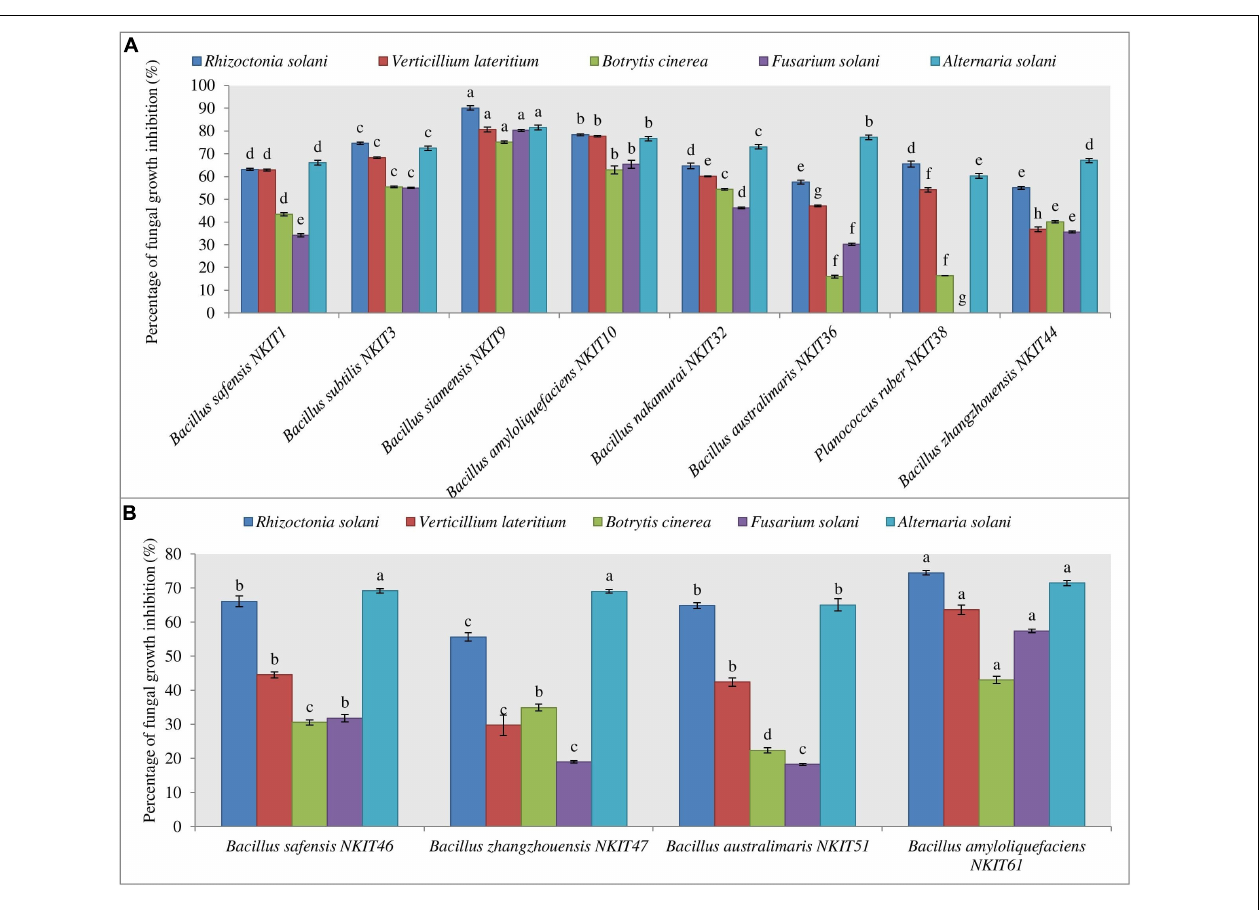
FIGURE 4 | Antagonistic effect against five pathogenic test fungi. (A) Graph for the antifungal activity of bacterial endophytes isolated from V1 variety seeds. (B) Graph for the antifungal activity of bacterial endophytes isolated from V2 variety seeds. Three replicates were used for the assay. Bars labeled with the same letters are not significantly different according to Duncan Multiple Range Test at p = 0.05. Vertical lines represent the standard errors of the